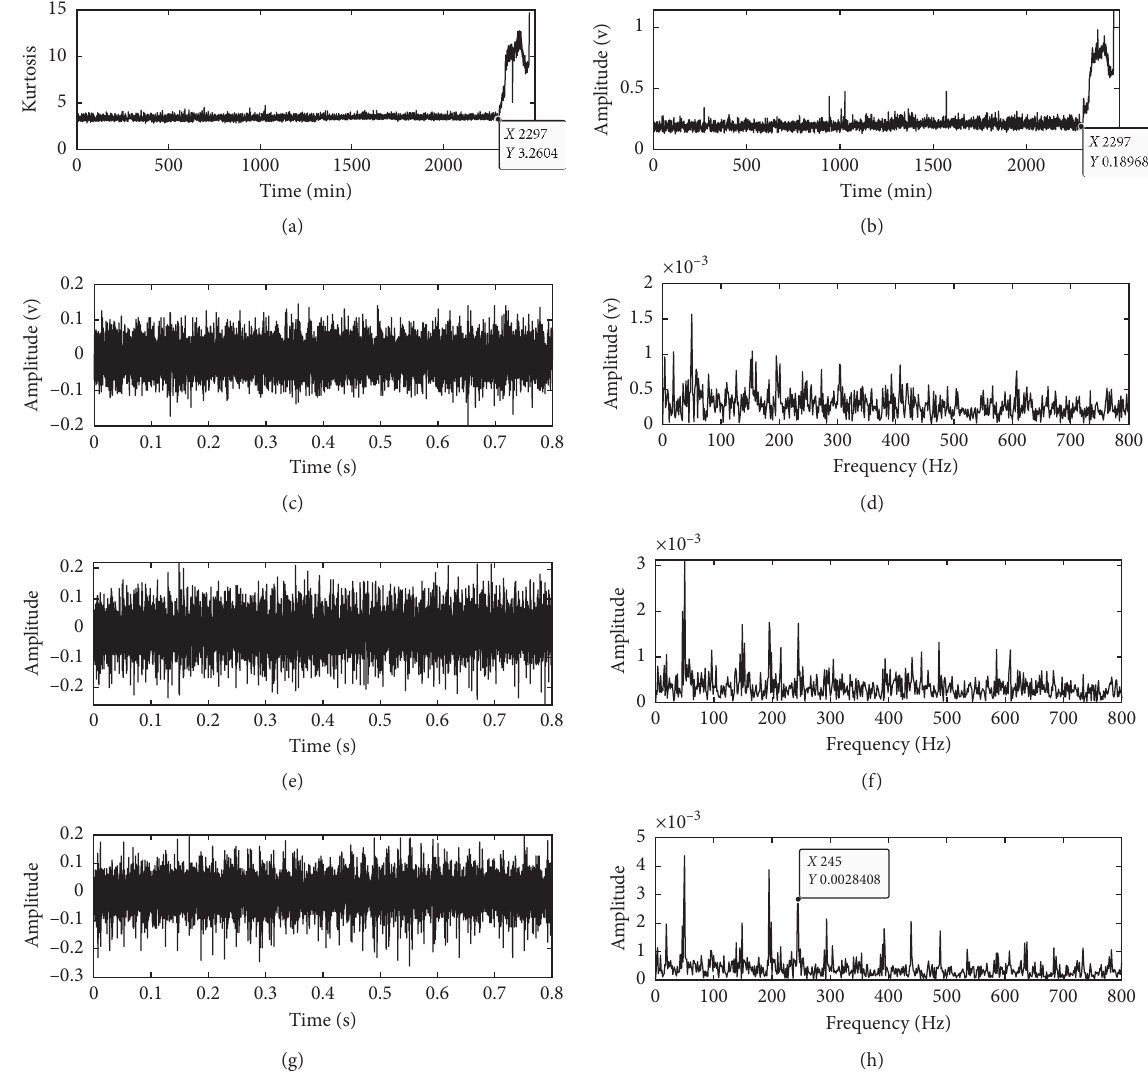
Figure 6: Early weak fault signal of test bearing: (a) kurtosis over its whole life of the test bearing; (b) amplitude over its whole life of the test bearing; (c) time-domain waveform of the signal at 2297 th min; (d) EDS of the signal as shown in Figure 6(c); (e) time-domain waveform of the signal at 2304 th min; (f) EDS of the signal as shown in Figure 6(e); (g) time-domain waveform of the signal at 2305 th min; (h) EDS of the signal as shown in Figure